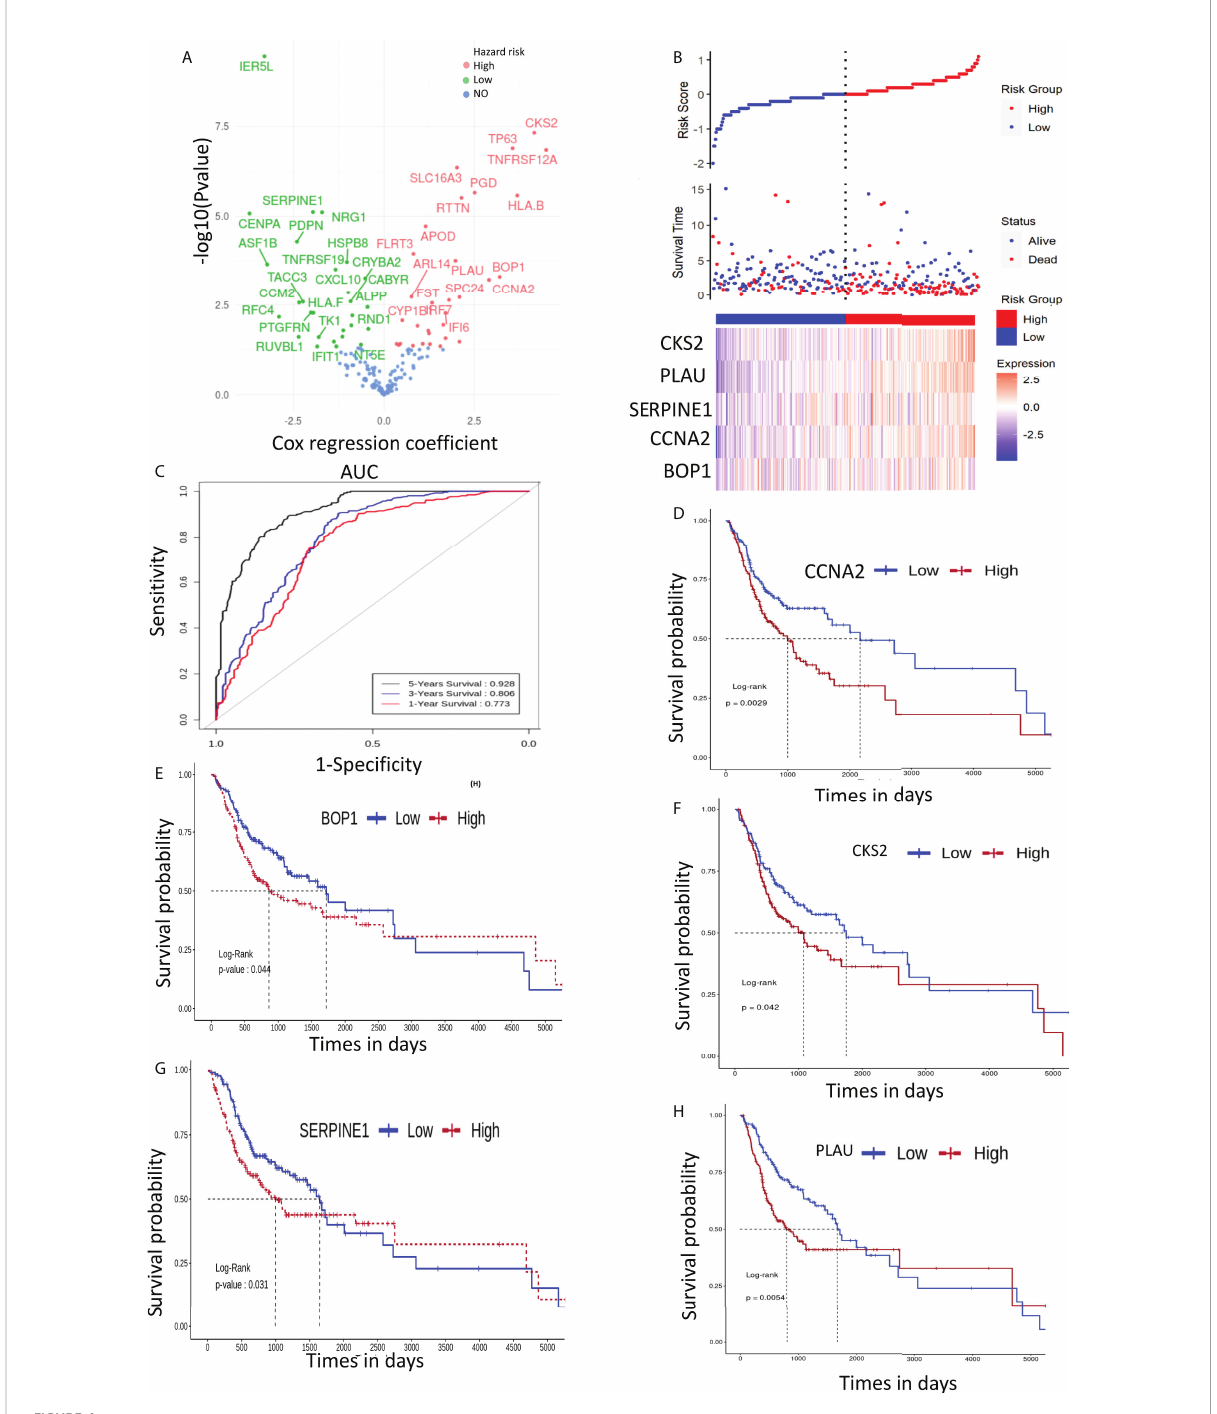
FIGURE 4 (A) Volcano plot of cox regression showing hazard ratio (HR) for 168 genes. (B) Patient strati fi cation according to risk score to predict the survival time of patients with high- and low-expression level of prognostic genes. (C) ROC depicting the effect of selected genes on overall survival (1, 3, and 5 years). (D – H) depict the effect of signature gene expression on overall survival of OSCC